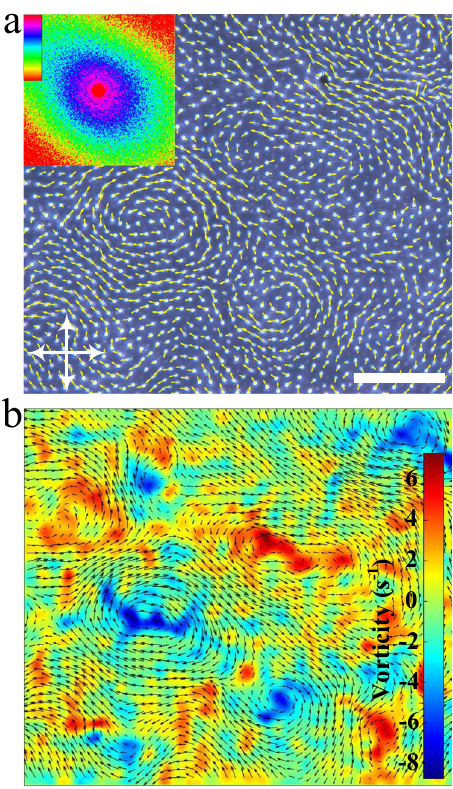
Fig. 9 Instantaneous velocity fi eld of directrons. a Polarizing microscopy of directrons with their velocities represented as small yellow arrows. U = 100 V, f = 500 Hz. The crossed white arrows indicate the polarizers. Scale bar 200 μ m. The inset represents the corresponding 2D spatial velocity correlation function colored according to the color bar which changes linearly from − 0.2 to 1. The image size of the 2D velocity spatial correlation function represent an area of 400 μ m × 400 μ m. The 2D spatial velocity correlation functions are averaged over ~1.4 s (20 frames). b Color map of vortices. The bar shows a linear scale of vorticity. The black arrows show the PIV fl ow fi eld.